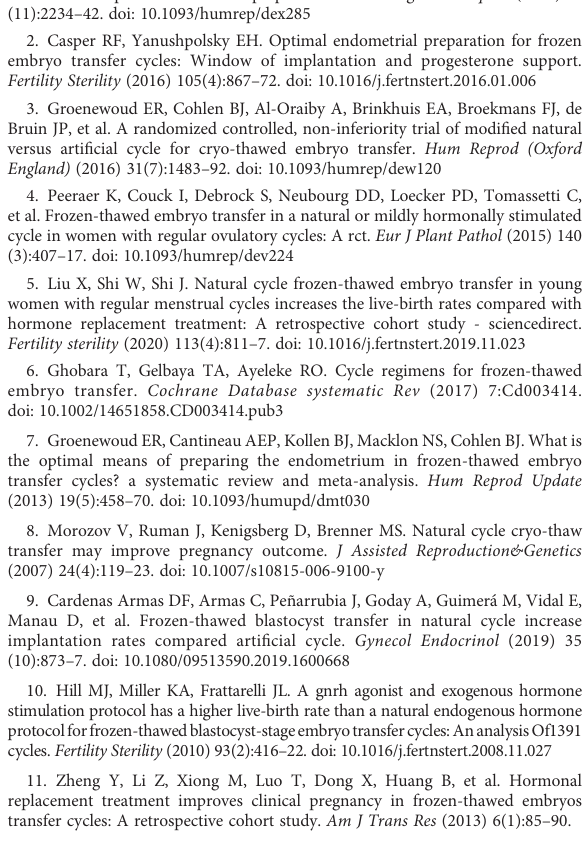
SUPPLEMENTARY FIGURE 1 Effect of endometrial preparation methods on live birth rate in each subgroup. Note: CI = con fi dence interval; OR = odds ratio; a Adjusted for female age at oocyte retrieval, BMI, infertile years and bFSH except the subgroup